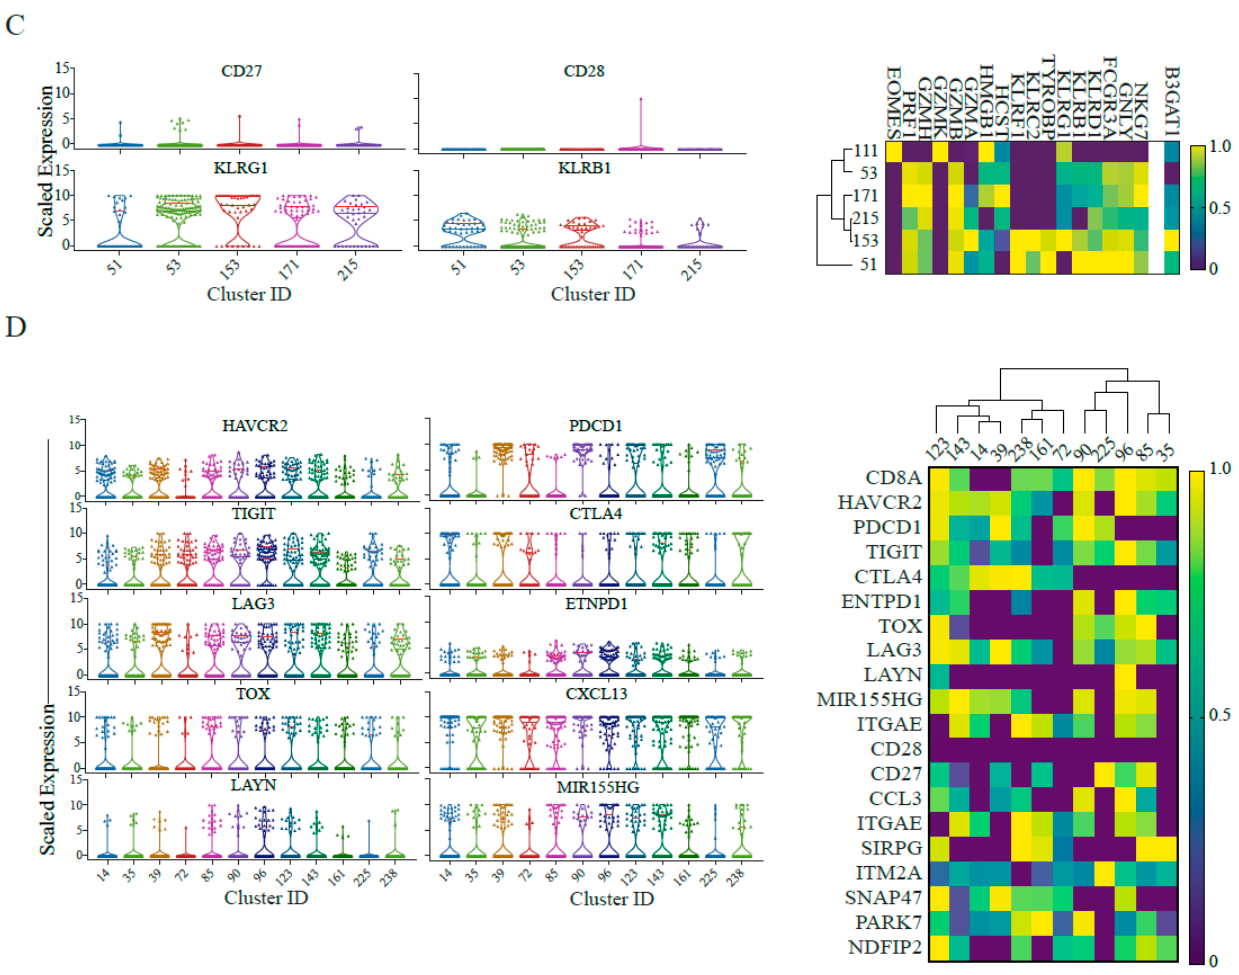
Figure 3. Single Cell RNA sequencing reveals senescence and regulatory signature of T-cells. ( A ) Left, ~13,600 T cells in tumour are projected on UMAP and clusters annotated by the major compartments including regulatory T-cell (pink), senescent T-cells (purple) and exhausted T-cells (cyan). Right, UMAP of the cluster identities in each of the major subsets. ( B ) Left, Violin plots depicting the 75th percentile scaled expression of the marker genes in the Treg clusters. Right, heatmaps showing the top differentially expressed genes in the Treg clusters. Expression has been normalised per gene. ( C ) Left, Violin plots of the 75th percentile expression of the key gene signature for the senescent population. Right, Heatmaps showing NK and senescence genes uniquely expressed in the senescent population. Heatmap scale for B3GAT1 is presented as mean values per cluster rather than the 75th percentile due to low capture of this gene. ( D ) Left, Violin plots of the 75th percentile expression of the key gene signatures for the exhausted T-cell population. Right, the corresponding heatmaps of the key gene signatures. Full expression profiles per cluster are provided in Supplemental Data File 2.